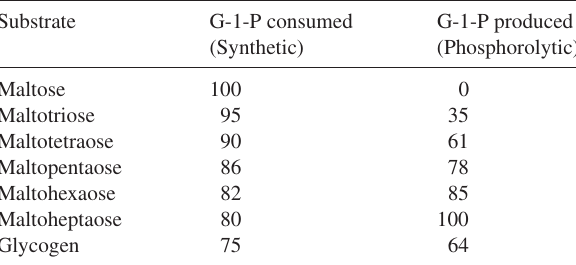
Table 2. Substrate specificity of α -glucan phosphorylase from Pyro- coccus furiosus in the synthetic and phosphorolytic directions in the presence of glucose-1-phosphate (G-1-P) after 30 min. Percent con - versions were calculated as the amount of sugar phosphate remaining in the reaction after incubation at a specified time, divided by the amount of substrate used in the reaction, and then multiplied by 100. The percent G-1-P produced was expressed as percent relative inten- sity (RI) which was calculated as: (RI of G-1-P from